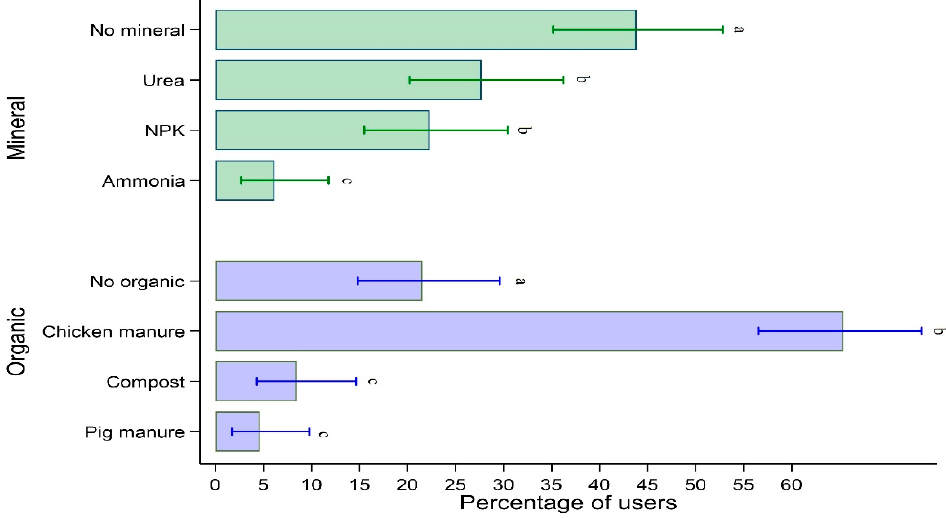
Figure 3. Probability of using fertilizers in the studied lowlands areas (at 95% confidence intervals).